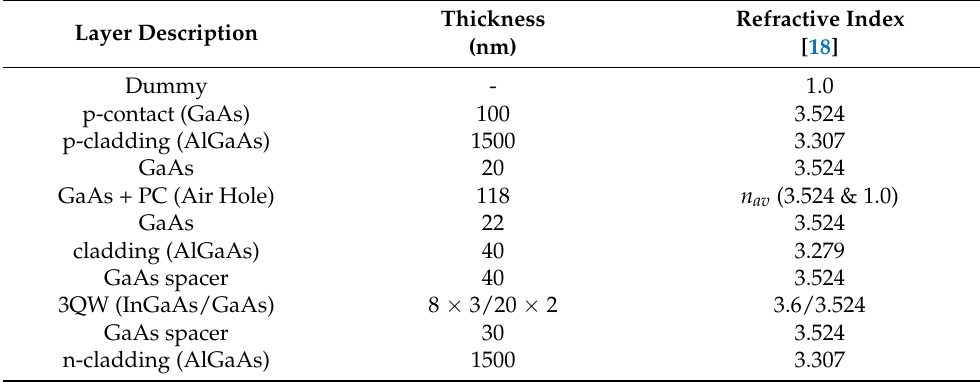
Table 1. The simulated layer structure of air-hole PC-SEL [18].